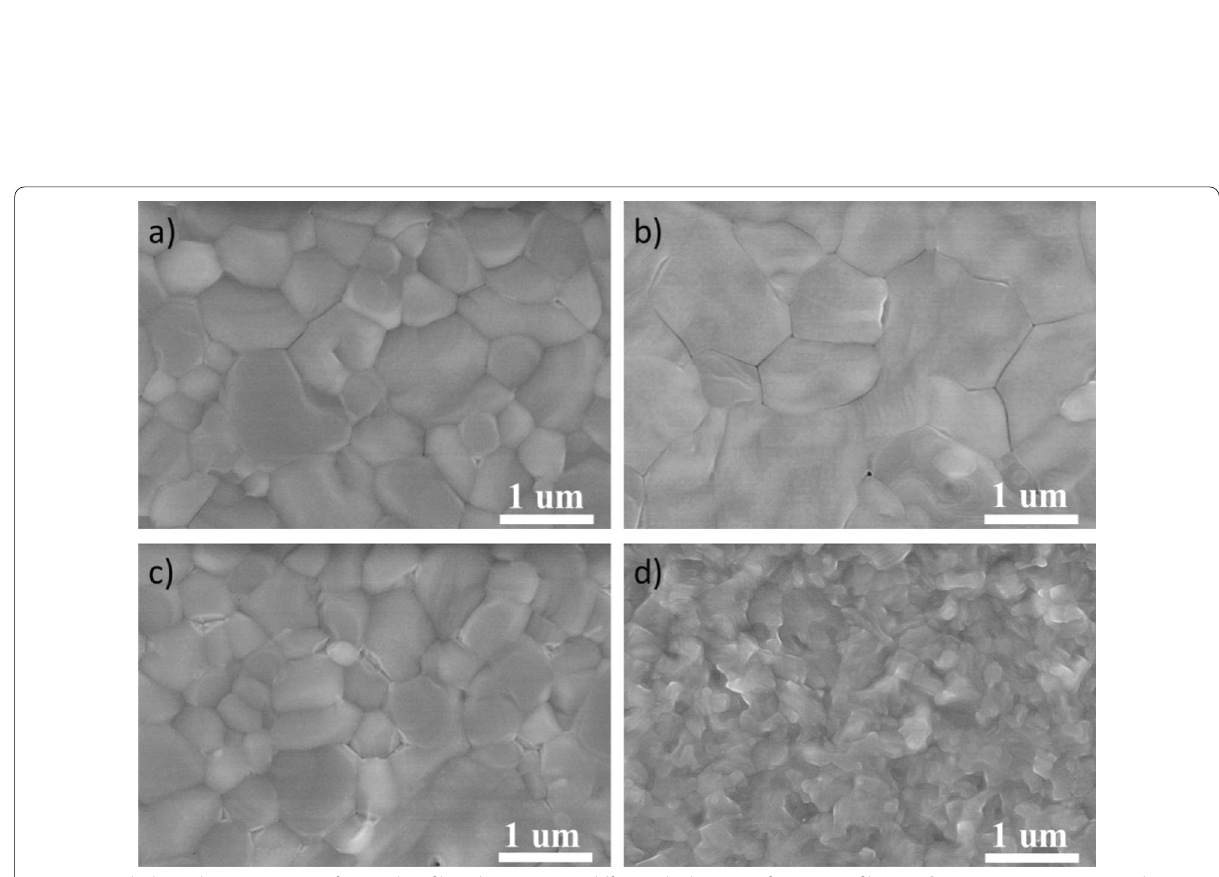
Fig. 4 Morphology characterization of perovskite films deposition on different thicknesses of Ni 3 (HITP) 2 films. a – d 20 nm, 30 nm, 40 nm, and 50 nm,